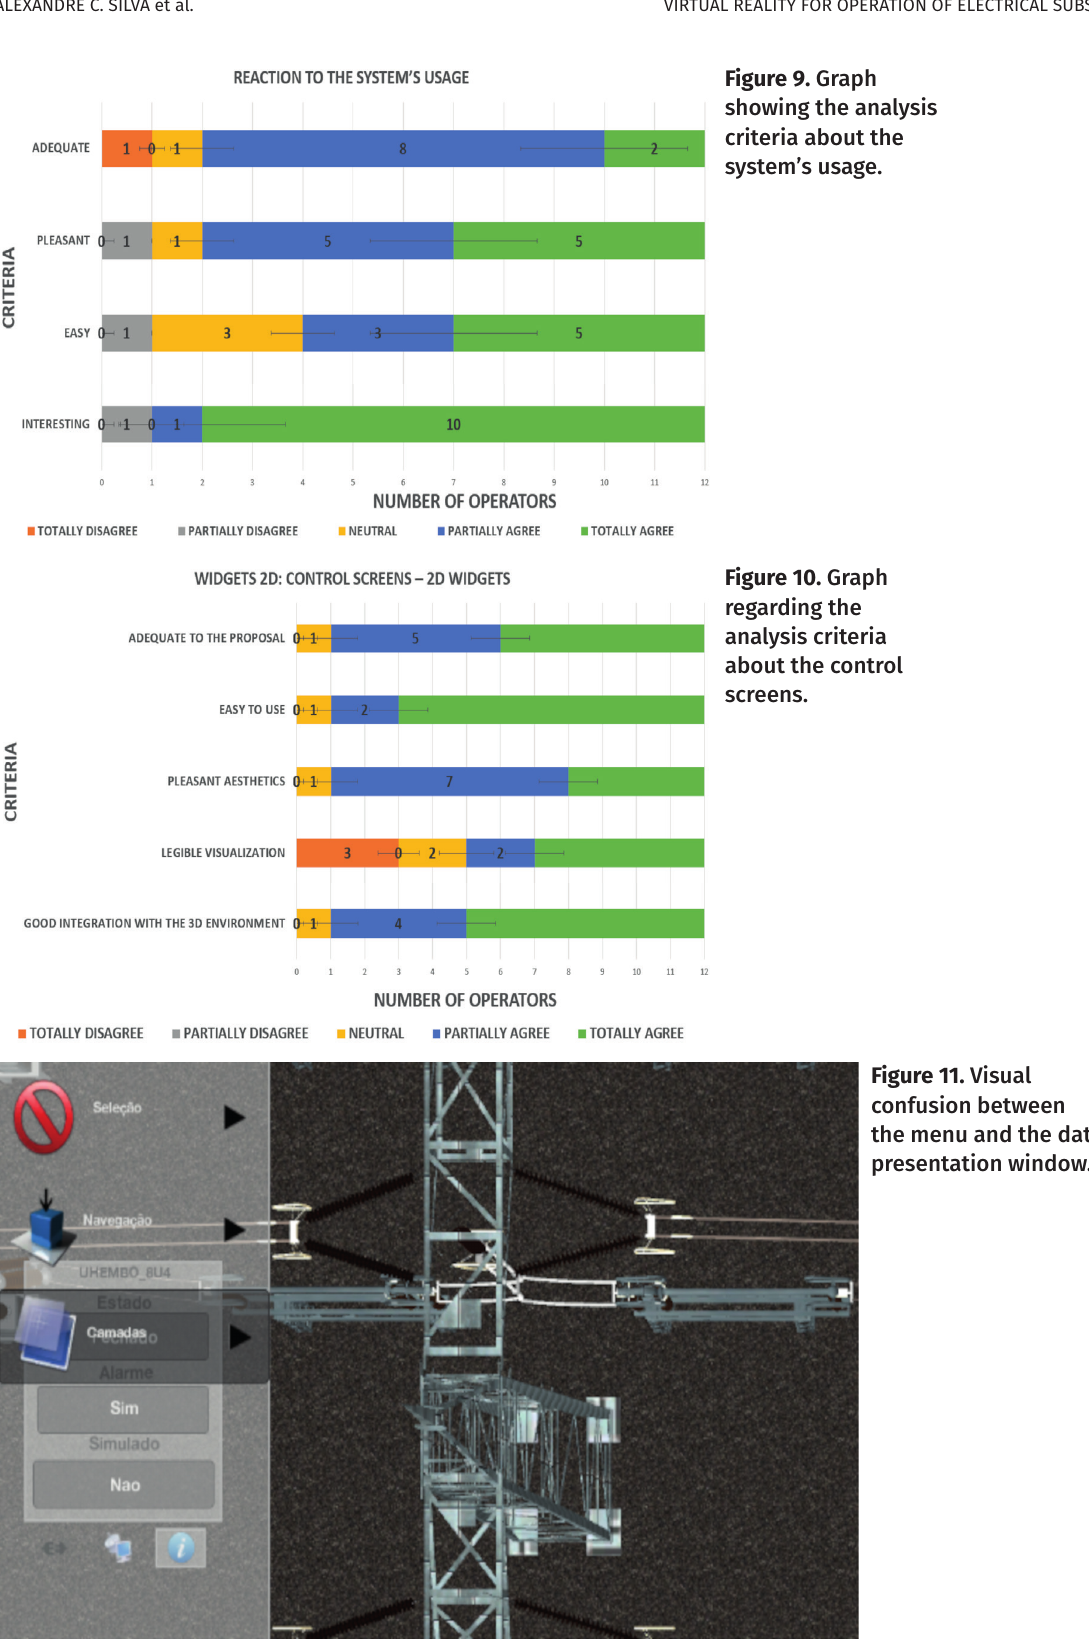
Figure 11. Visual confusion between the menu and the data presentation window.